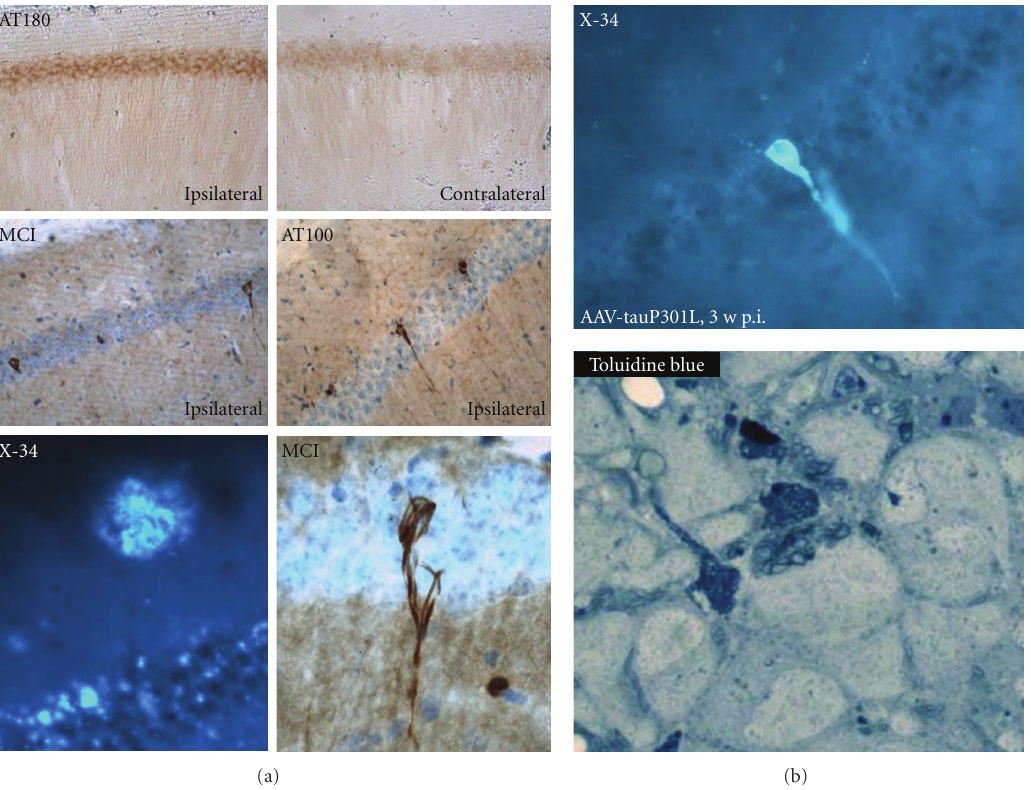
Figure 2: Protein Tau is activated by and therefore downstream of amyloid pathology. (a) Tau.P301L transgenic mice [36] were injected intracerebrally at age 1.5 months with either AAV-APP.SLA vector (10e8 tu) or with AAV-EGFP as control. At 6 months p.i. the expression of APP.SLA, unlike EGFP, led to formation of amyloid aggregates and plaques, as shown by histochemical staining with X34 (lower left panel). The mutant APP.SLA also strongly increased the phosphorylation of transgenic Tau.P301L resulting in the formation of neurofibrillary tangles already at this age of the Tau.P301L mice in pyramidal neurons of CA1: immunohistochemistry with Mab AT180 specific for phospho-T231-Tau (upper panels), Mab MC1 (conformational Tau-epitope) (middle panel left) and Mab AT100 (phospho-S212/T214) (middle panel right). Remarkably, the amyloid plaques and Tau pathological aggregates coexist in AAV-APP.SLA-injected Tau.P301L mice without causing appreciable neurodegeneration. (b) Intracerebral injection of AAV-Tau.P301L (10e8 tu) in wild-type mice produced extensive neurodegeneration of CA1 pyramidal neurons as shown before [11]. Aggregates of Tau or tangles were very rare although they can form in these neurons in the experimental conditions, as shown histochemically with compound X34 as sensitive probe for β -sheeted aggregated protein [12, 14]. Clearly, the paucity of tangles cannot explain the extensive neuronal cell death. Degenerating neurons share morphological features of necrosis and autophagy, with extensive vacuolization as demonstrated histochemically by toluidin blue staining (bottom